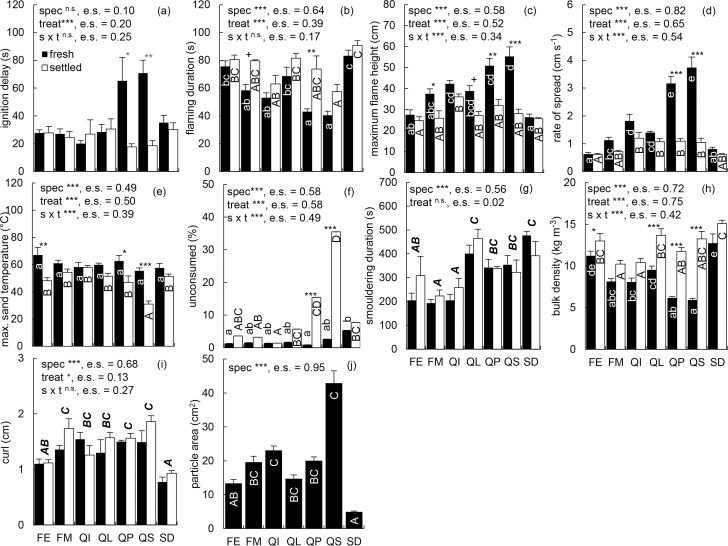
Means and standard errors with results of the ANOVA.(a) ignition delay (ID), (b) flaming duration (FD), (c) maximum flame height (FH), (d) rate of spread (RoS), (e) maximum sand temperature at 10 mm depth (ST), (f) unconsumed (UC), (g) smouldering duration (SD), (h) bulk density (BD), (i) curl and (j) particle area. Species are indicated as follows: F. excelsior (FE), F. mandshurica (FM), Q. imbicaria (QI), Q. libani (QL), Q. palustris (QP), Q. shumardii (QS), S. domestica (SD). Significance of species (spec), treatment (treat) and their interactions (s x t) was checked by means of Two -Way ANOVA for all characteristics except area, for which One-Way ANOVA with spec as fixed factor was applied. Effect size (e.s.), calculated as the partial eta-squared, is reported. ANOVA was followed by pairwise contrasts with Tukey’s adjustment for multiple comparisons. Different lowercase letters indicate statistically significant differences (P ≤ 0.05) within the fresh treatment, different capital letters indicate statistically significant differences within the settled treatment, and bold-italic capital letters are used to indicate significant between species differences when comparison was done only on the species level as treatment effects were not significant (SD and curl). For ID, ANOVA showed no significant species effect. Therefore, we do not report results of the within treatment between species pairwise contrasts for this characteristic. Significance of the fixed factor effects as indicated by ANOVA and significance of the within species treatment effects as determined by pairwise contrasts are indicated as: n.s. P > 0.10, + P ≤ 0.10, *P ≤ 0.05, **P ≤ 0.01 and ***P ≤ 0.001.